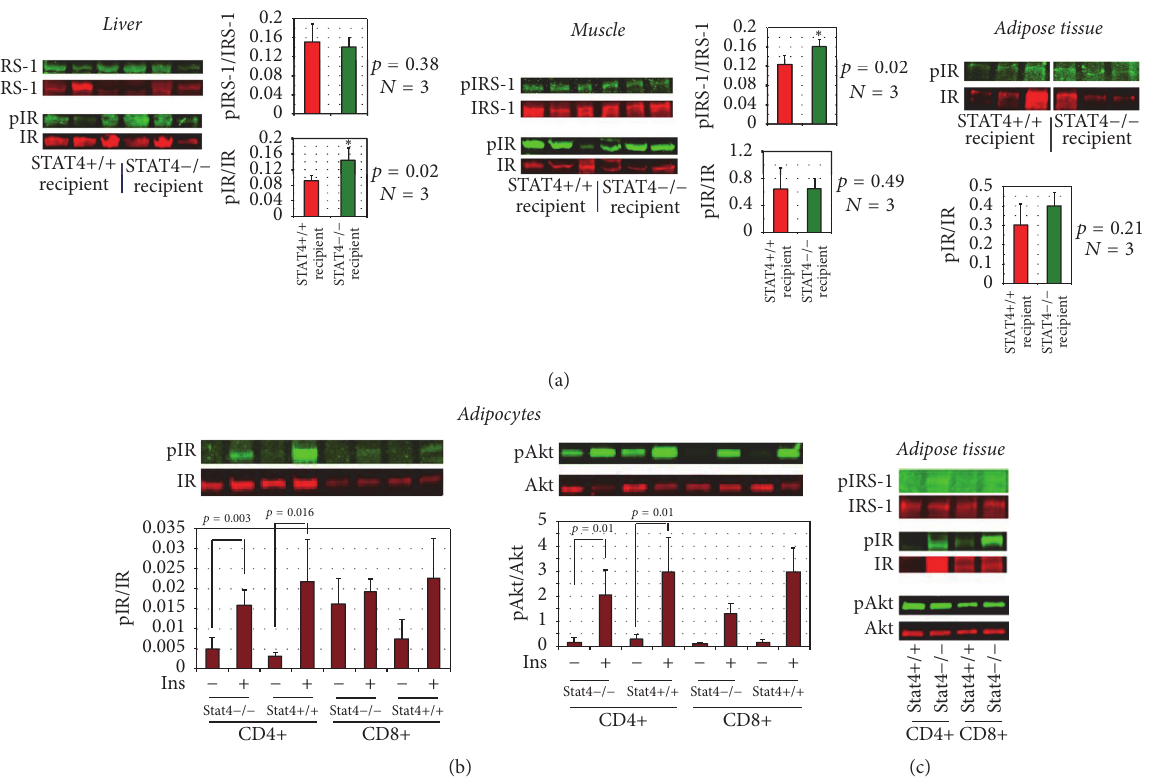
Figure 6: Insulin signaling in chimeric mice following bone marrow transplant and in Rag1 − / − mice following adoptive transfer and HFD. (a) Chimeric mice following BMT. STAT4 − / − and STAT4+/+ recipient mice ( 𝑛 = 3 /group) were injected i.p. with a 10U/kg insulin bolus and tissues were harvested after 10 minutes. Western blot analysis showed increased activation of the insulin receptor (pIR) in liver and insulin receptor substrate-1 (pIRS-1) in muscle of the STAT4 − / − recipient mice; no differences were found between the two groups in epididymal adipose tissue. Data represents mean ± SD; ∗ 𝑝 < 0.05 . ((b) and (c)) Rag1 − / − mice following adoptive transfer. Adipocytes (b) were isolated from epididymal adipose tissue of different mice groups and stimulated in vitro with 5 nM insulin, for 30 min. Insulin receptor-1 and PKC (Akt) activation were measured by western blot ( 𝑛 = 3 -4/group). (c) Mice were injected with an insulin bolus (10U/kg) and euthanized after 10 minutes. Adipose tissue was harvested and processed immediately for western blot analysis. Results are representative for 2-3 mice/group.